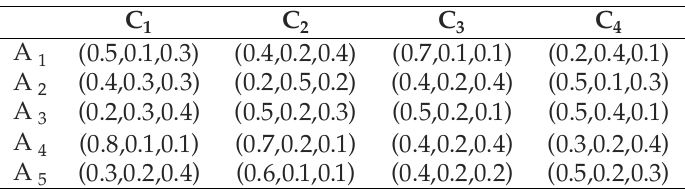
Table 1. Picture fuzzy decision